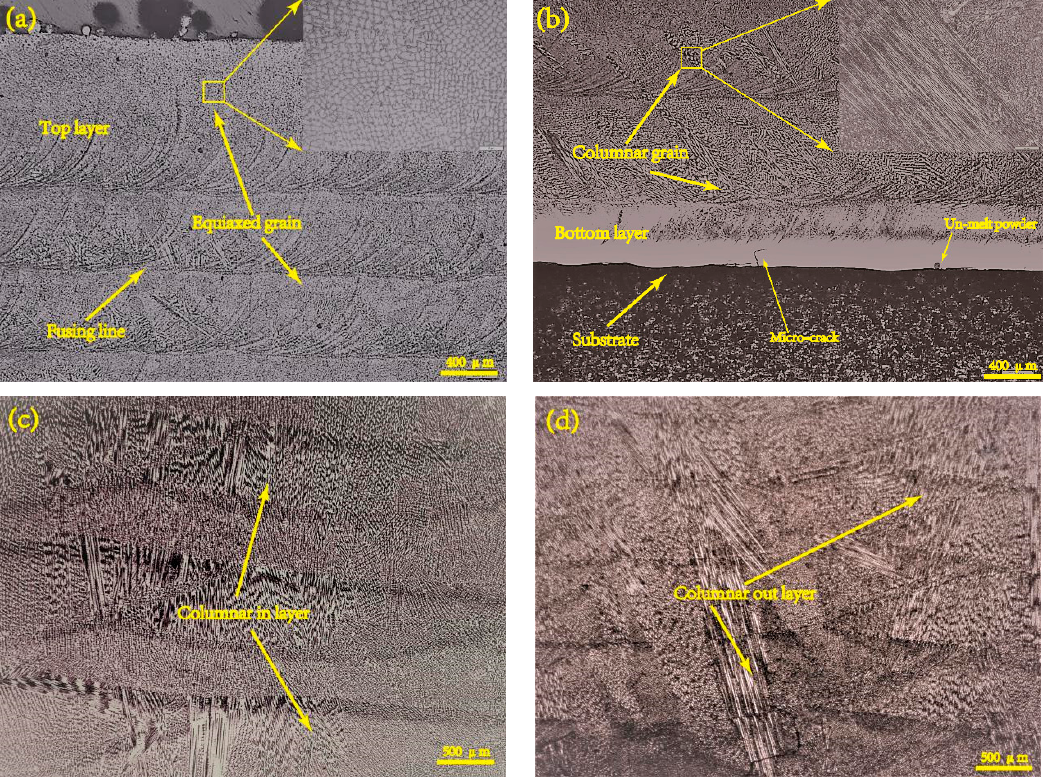
Figure 2. Optical micrograph of deposited specimens in ( a ) top area and ( b ) bottom area; two types of columnar grain ( c , d ) in middle